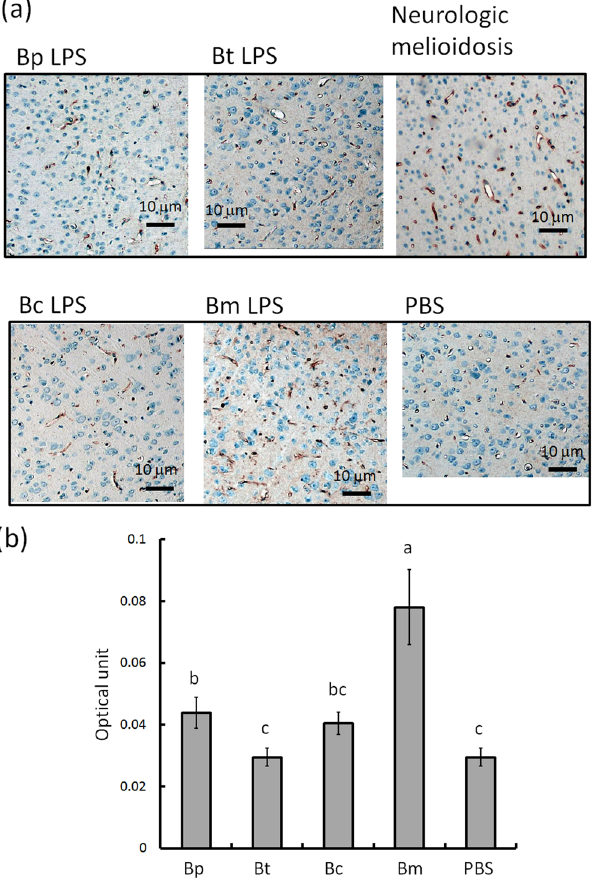
Figure 4. Endothelial activation. The expression of the endothelial marker CD34 in the cerebral cortex is shown in representatives of four types of Burkholderia LPS-induced, PBS-treated and neurologic melioidosis brains ( a ). The optical units of the CD34-positive areas were calculated using ImageJ software (open source, https://imagej.net/Fiji) ( b ). The letters a-c represent significant differences at p < 0.05 (one-way ANOVA; Tukey’s post hoc